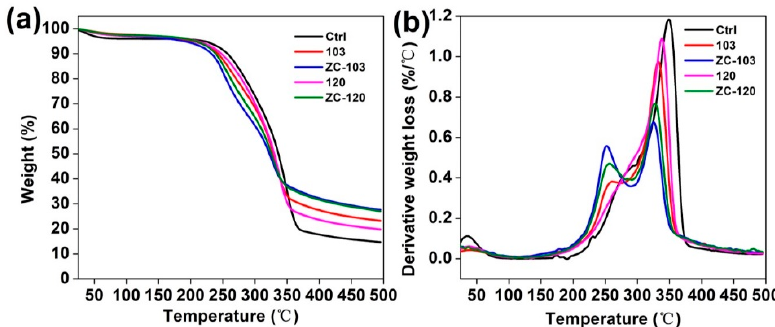
Figure 10. TGA ( a ) and differential thermogravimetric (DTG) ( b ) curves of the 10% DM + 10% MA-treated samples in different groups. Table 2. Thermal properties of the 10% DM + 10% MA-treated samples in different groups. T onset : decomposition onset temperature; T max : maximum decomposition rate temperature; T end : decomposition termination temperature.